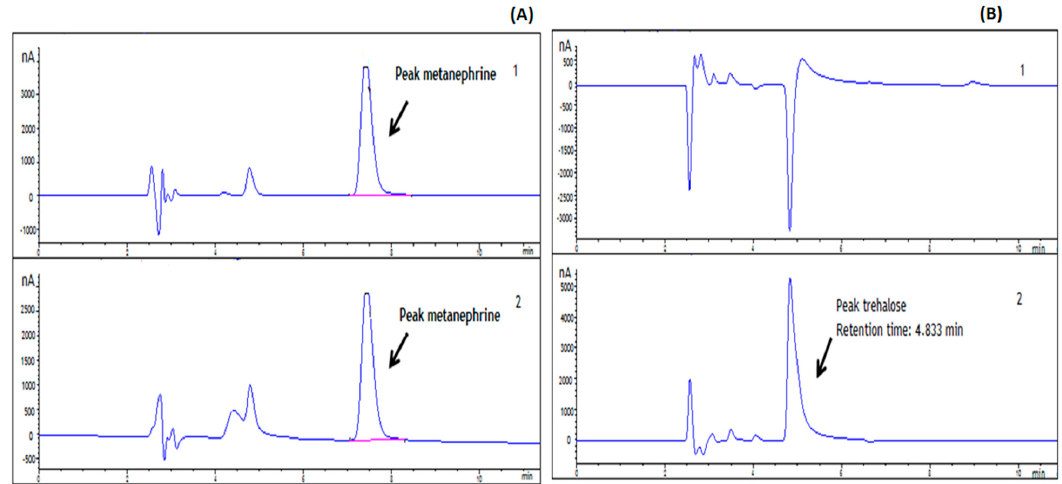
Figure 2. ( A ) Chromatogram of a metanephrine standard; ( B ) Chromatogram of a 300 mM trehalose standard. ( 1 ) Oxidation potential (+410 mV) and ( 2 ) reduction potential ( − 350 mV).